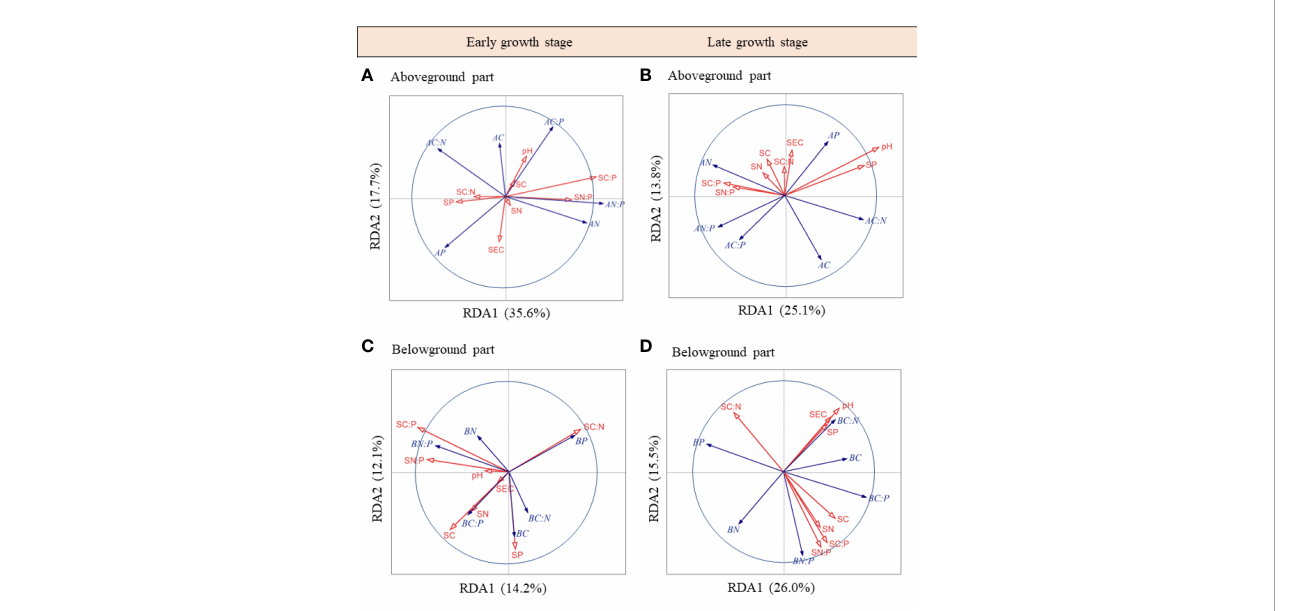
FIGURE 4 RDA-ordination biplot of the above- and belowground parts C, N, P stoichiometries and soil properties in the early (A, B) and late growth stages (C, D) . AC, aboveground part C concentration; AN, aboveground part N concentration; AP, aboveground part P concentration; AC:N, aboveground part C:N ratio; AC:P, aboveground part C:P ratio; AN:P, aboveground part N:P ratio; BC, belowground part C concentration; BN, belowground part N concentration; BP, belowground part P concentration; BC:N, belowground part C:N ratio; BC:P, belowground part C:P ratio; BN:P, belowground part N: P ratio; SC, soil C concentration; SN, soil N concentration; SP, soil P concentration; SC:N, soil C:N ratio; SC:P, soil C:P ratio; SN:P, soil N:P ratio; pH, soil pH; SEC, soil electrical